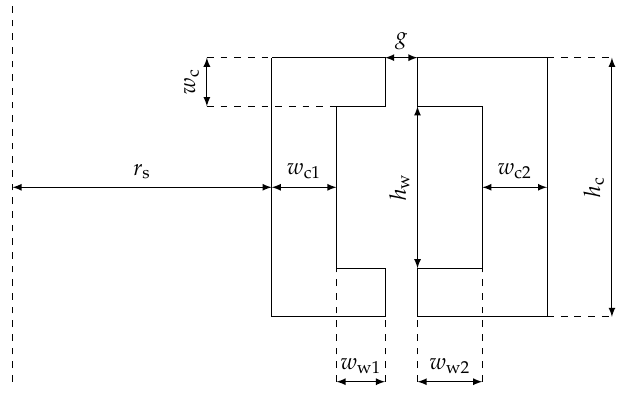
Figure 8. Geometrical parameters of the magnetic